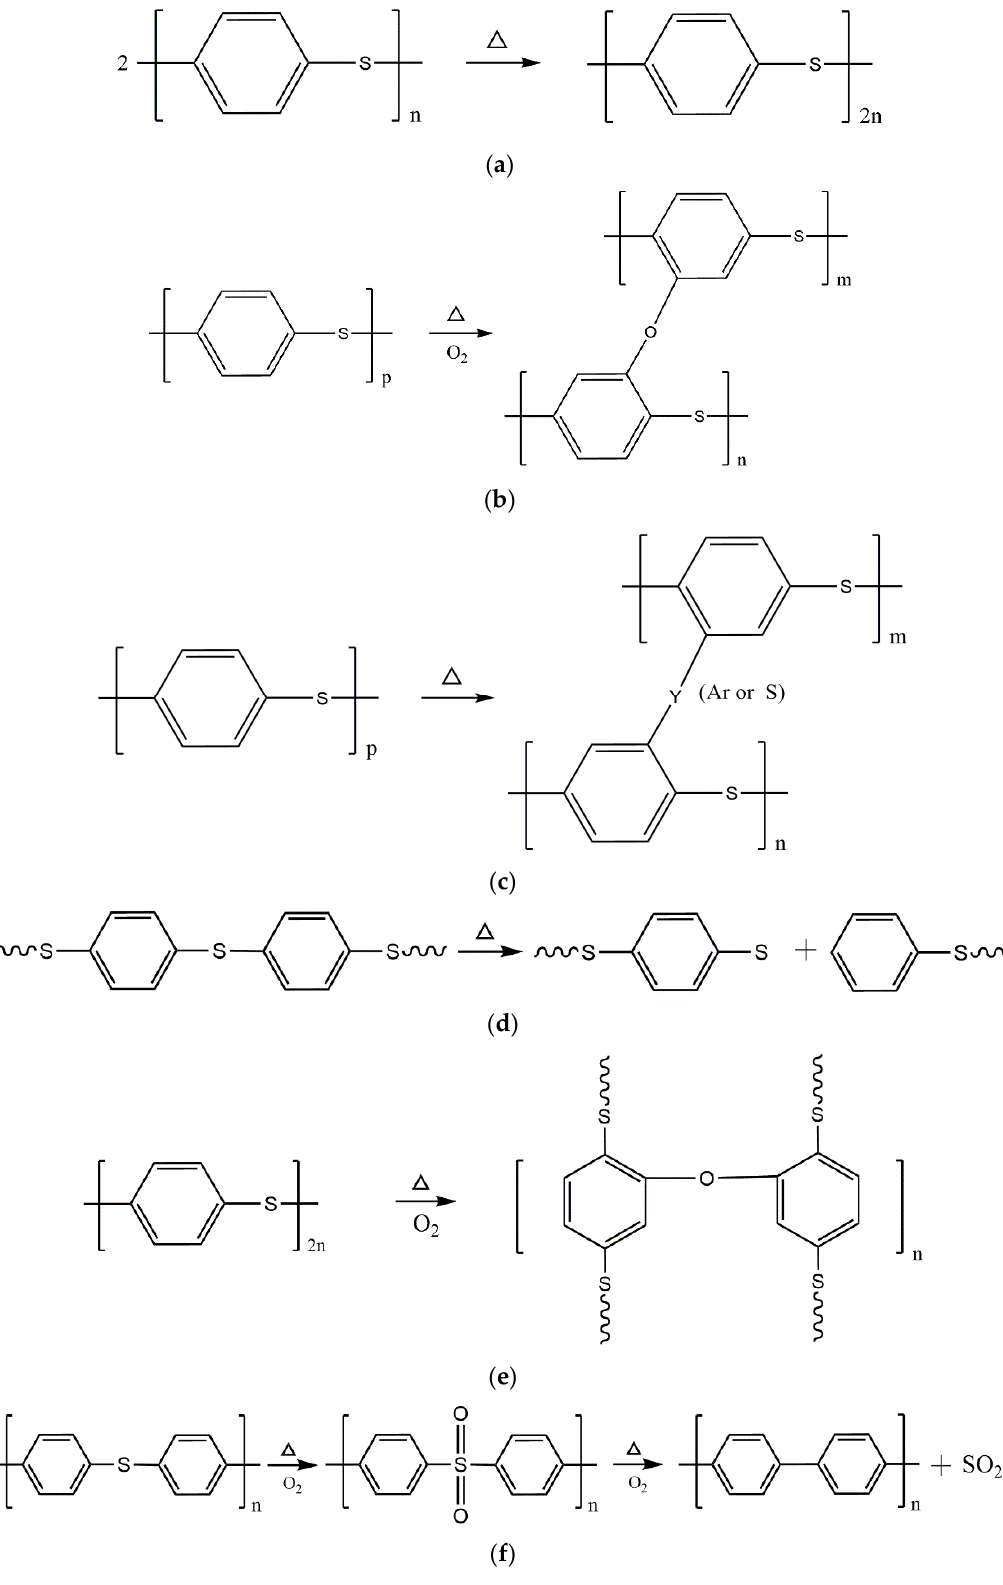
Figure 10. The principle of the oxidation reaction of polyphenylene sulphide. ( a ) chain amplification. ( b ) oxidative crosslinking reaction. ( c ) Thermal crosslinking reaction. ( d ) C Mel S bond breakage. ( e ) oxidative damage. ( f ) further oxidative damage.